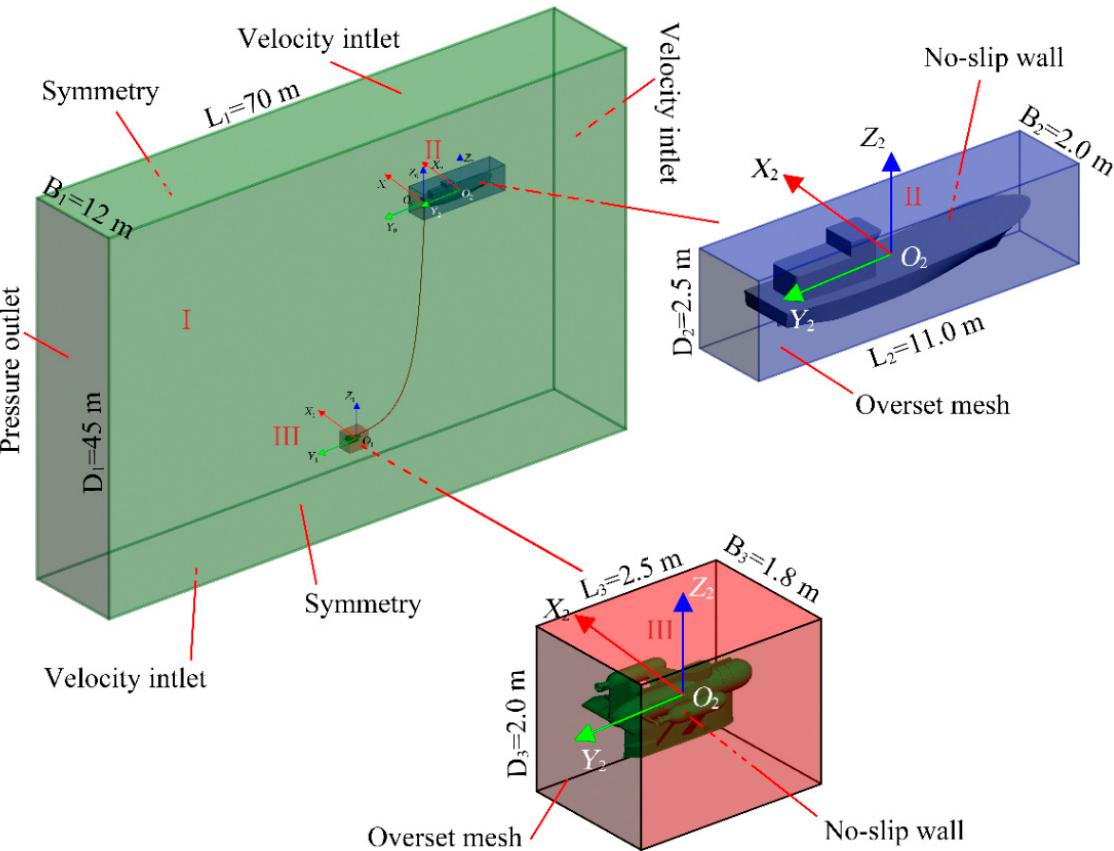
Figure 3. Computational domains and boundary conditions.